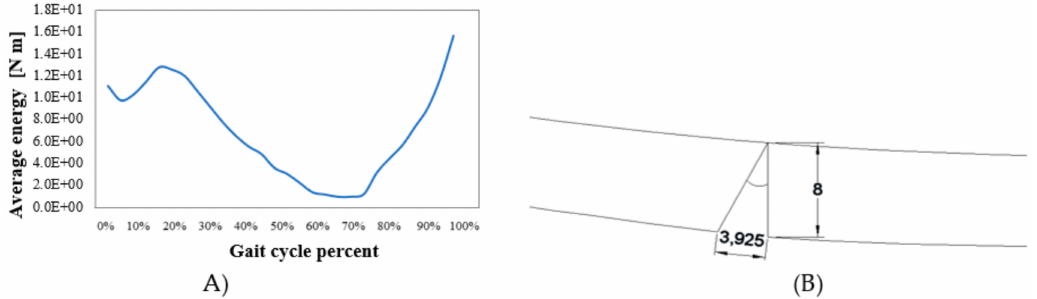
Figure 18. Case 3 results. ( A ) Deformation energy in the cross section of MF during the support phase of the walking cycle. ( B ) Final dimensions of the hinged